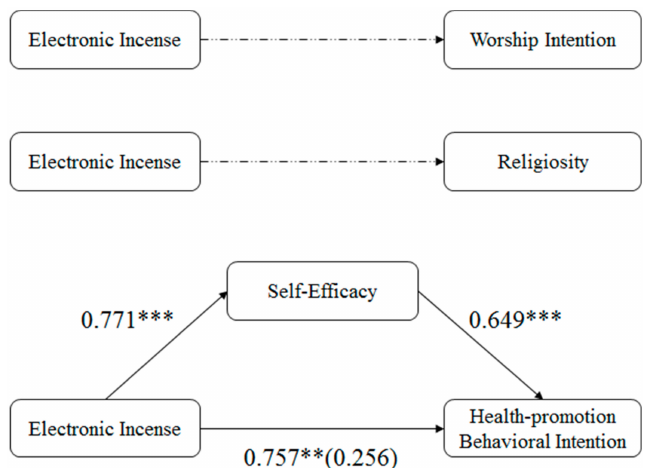
Figure 6. All psychological paths revealed in this study. Note: Dashed line means insignificance; solid line means significance; ** means p < 0.05; *** means p <